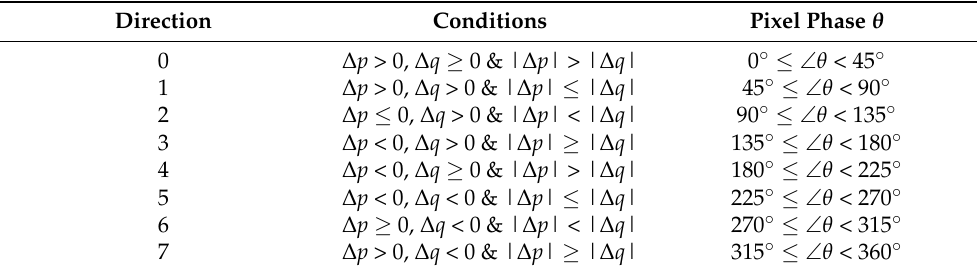
Figure 6. ( a ) The proposed TI algorithm for direction recognition; ( b ) The ratio of hypotenuse to the leg has maximum value when Δ p = Δ q . Table 1. Angle range condition and direction distribution .